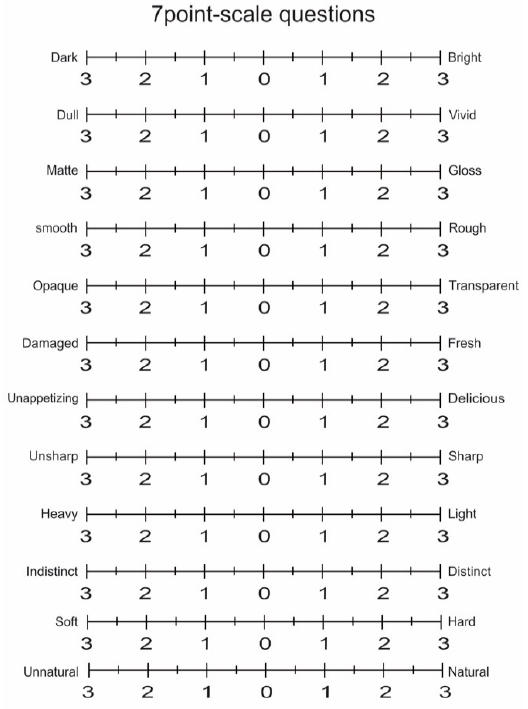
Figure 6. Twelve questions of seven-point scale.